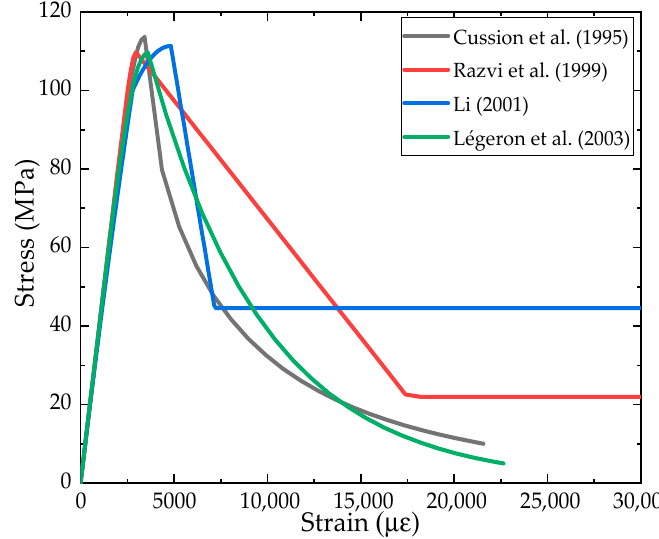
Figure 2. Comparison of the main models ( 𝑓 (cid:3030) = 100 MPa) [9,15,20,21].